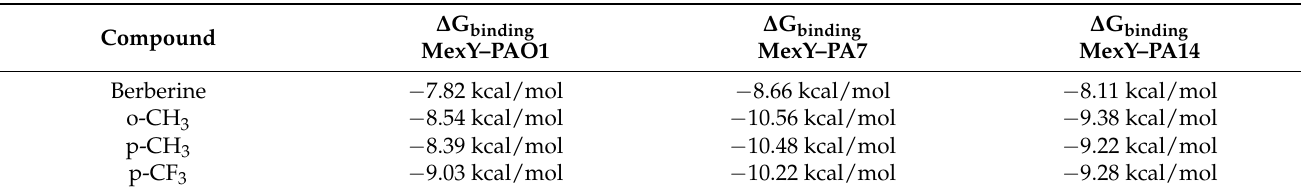
Figure 3. Best-scored docking poses of ligands within MexY proteins. Berberine is represented in yellow while the aromatic monosubstituted derivatives are p-CF 3 (blue), o-CH 3 (cyan), and p-CH 3 (light green). ( A ) MexY–PA7 protein with the periplasmic site represented in light blue ribbons; interacting residues are evidenced with a label and a side chain. ( B ) MexY–PAO1 protein with the site cleft represented in light purple ribbons; interacting residues are evidenced with a label and a side chain. ( C ) MexY–PA14 protein with the site cleft represented in light orange ribbons; interacting residues are evidenced with a label and a side chain. Table 2. Free binding energy of berberine and its derivatives (o-CH 3 , p-CH 3 , p-CF 3 ) in the best-scored poses for PAO1, PA7, and PA14